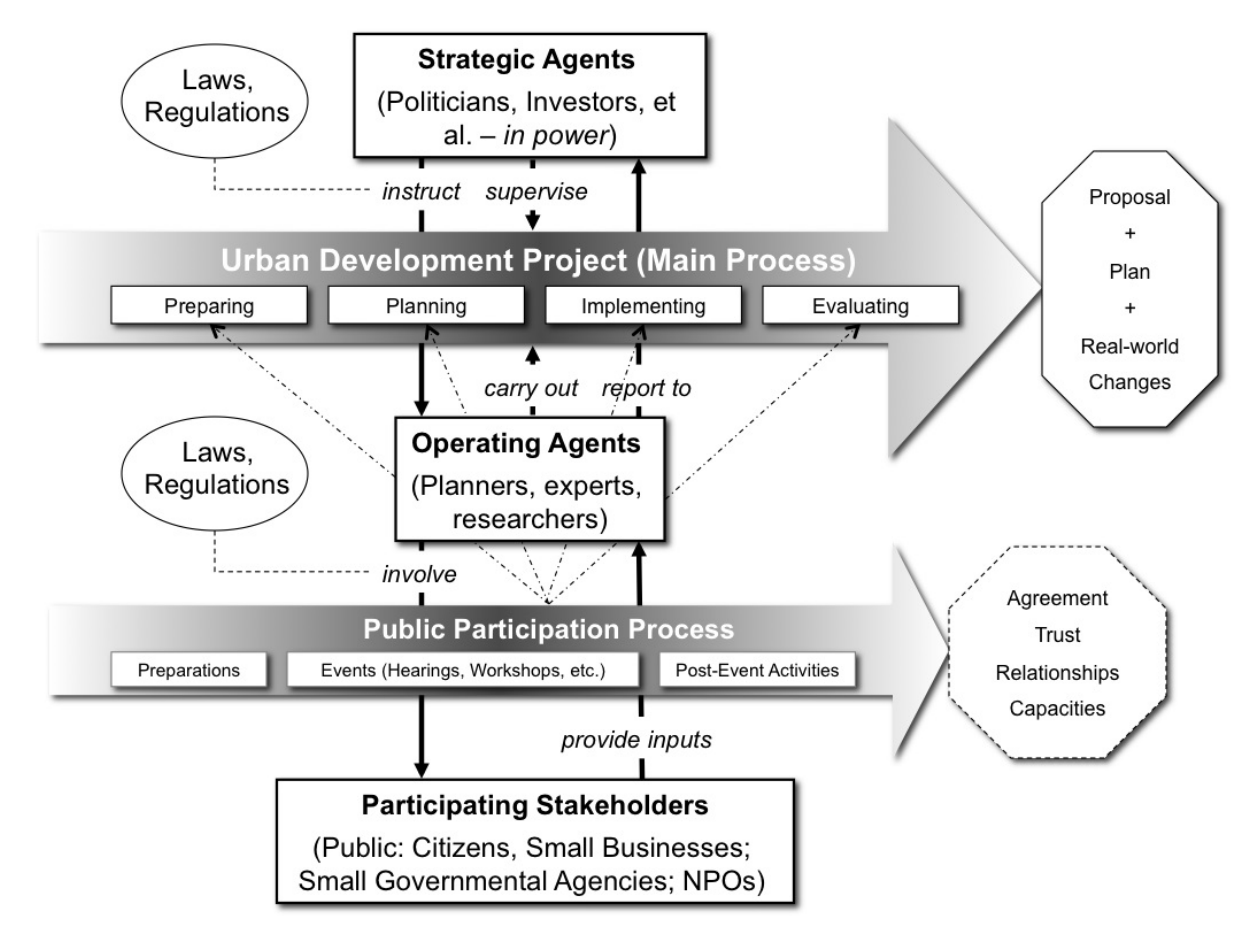
Figure 1. Key features of public participation in urban development projects (adapted from